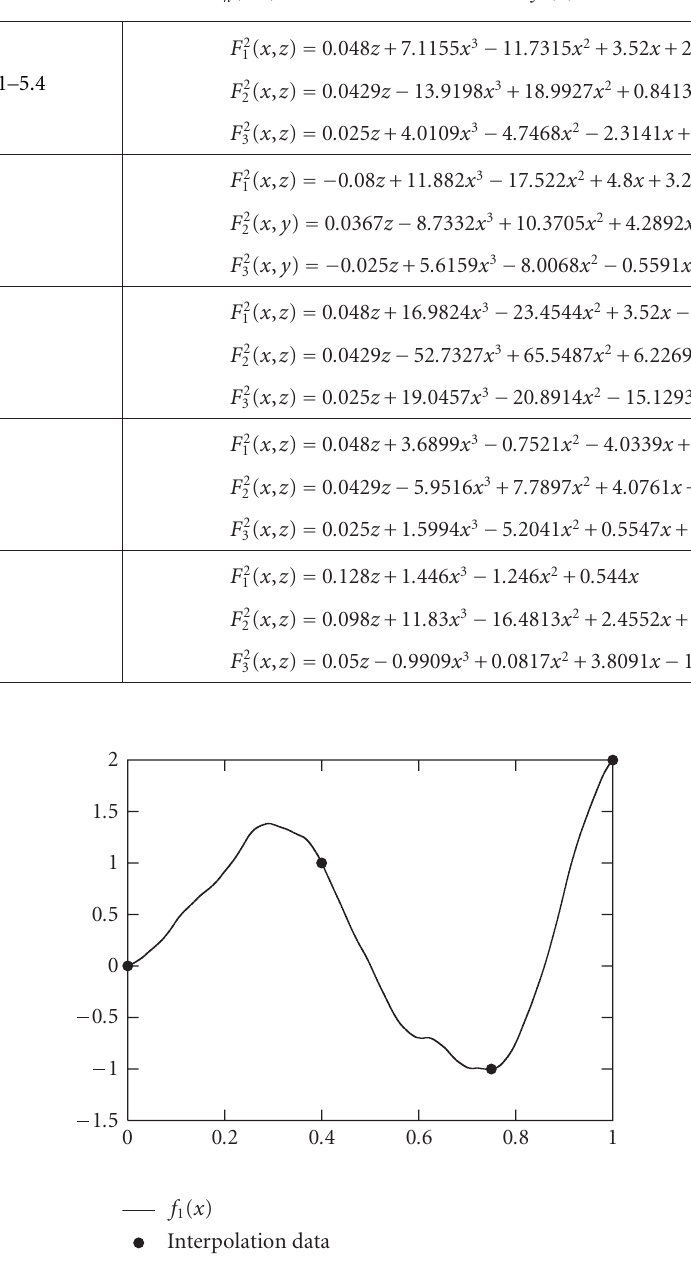
Table 5.1. F 2 ( x , z ) used in the construction of f 1 ( x ). n